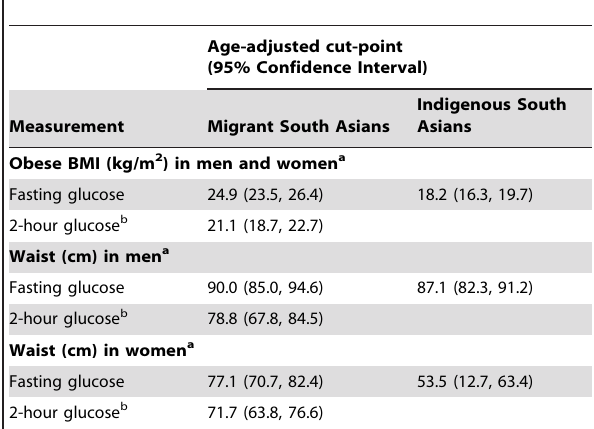
Table 2. Body mass index and waist circumference cut-points for people of South Asian ethnicity equivalent in terms of glucose levels to those in people of white